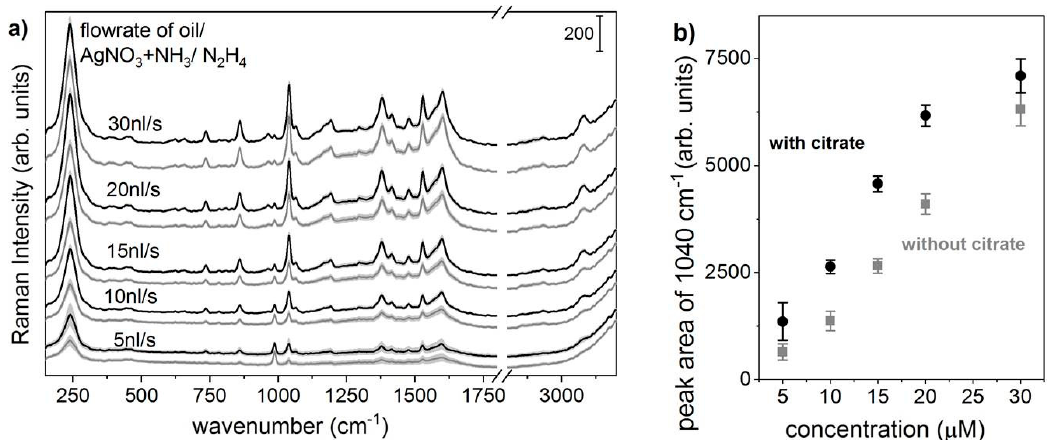
Figure 2. ( a ) Varying flowrates for mineral oil, AgNO 3 with NH 3 and N 2 H 4 in the microfluidic chip device. The flowrates of PZA (10 − 4 M) and NaNO 3 were kept constant at 10 nL / s. With the addition of citrate (10 − 5 M) depicted in black, without citrate plotted in gray. In light gray the standard deviation values are indicated. ( b ) Integrated intensity of the peak at 1040 cm − 1 relative to the di ff erent flowrates. With addition of citrate (10 − 5 M) depicted in black, without citrate plotted in gray, respectively.